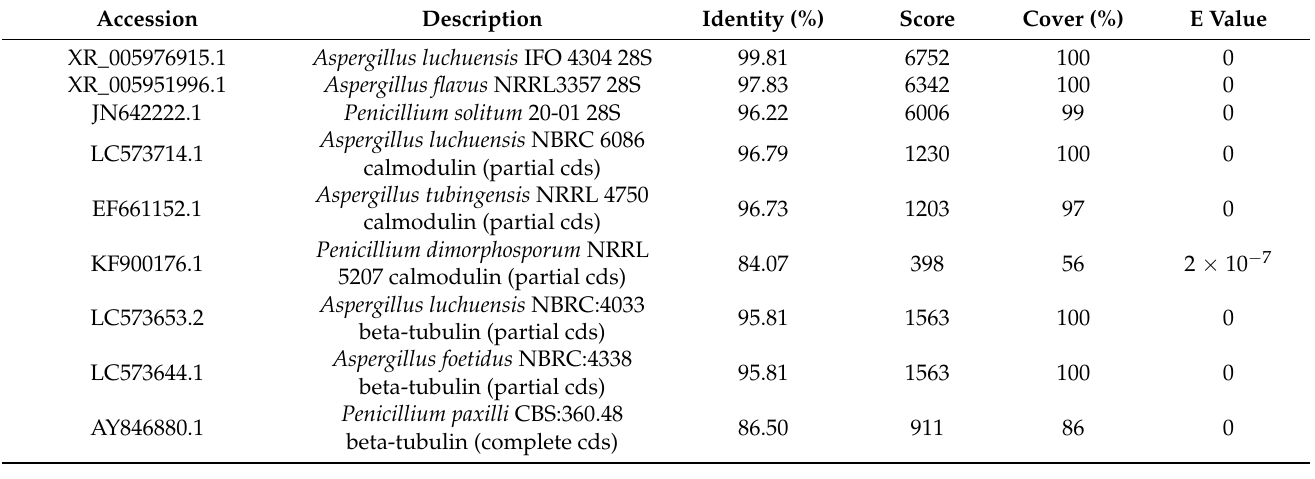
Table 2. Closest neighbors for Aspergillus luchuensis strain C7 based on 28S, calmodulin and β -tubulin markers blast comparison. Only three representative hits are shown per marker.